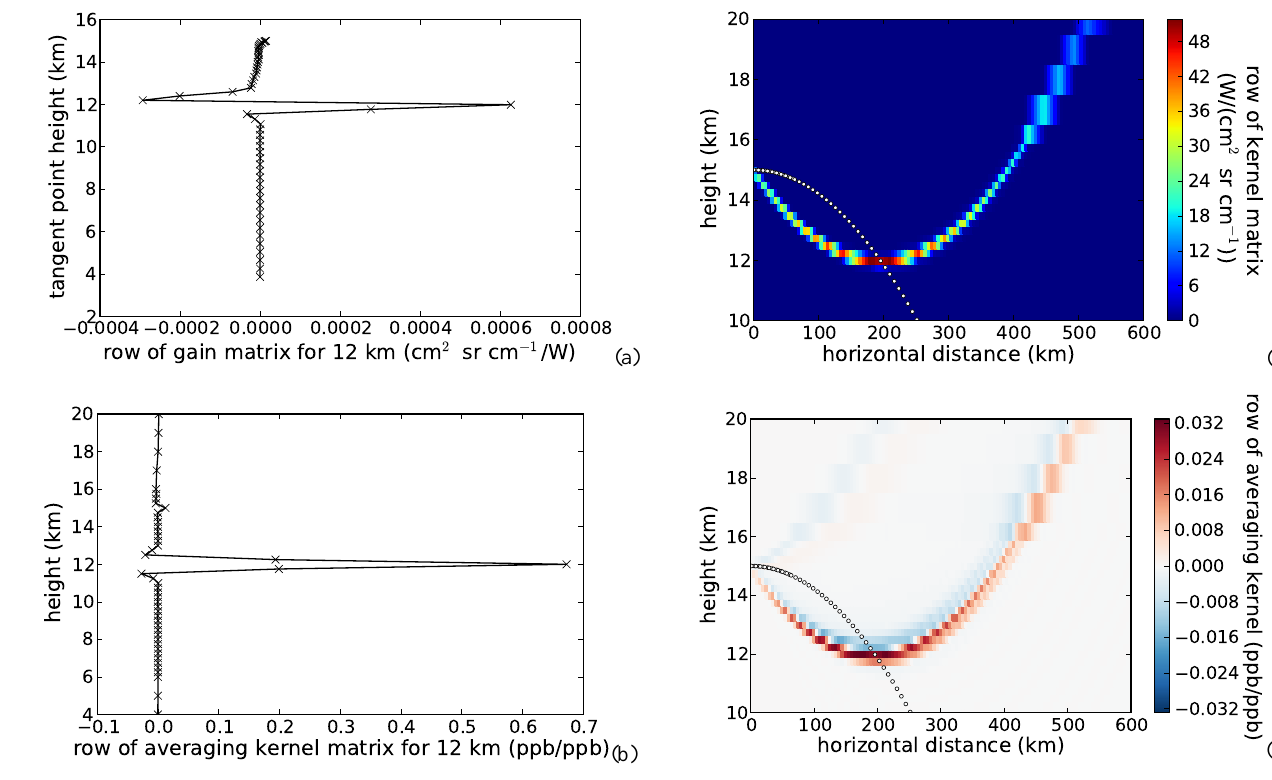
Fig. 15. (a) Shows the row of the gain matrix corresponding to the retrieval result at 12km. (b) Shows the row of the 1-D averag- ing kernel matrix describing the relationship between the true atmo- sphere and the 1-D retrieval result at 12km.